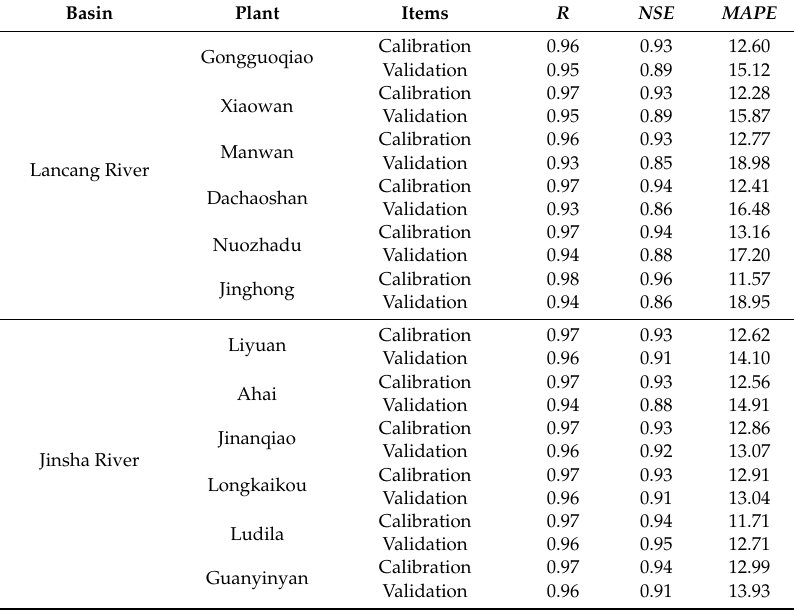
Table 3. The training and validation statistical indicators of each